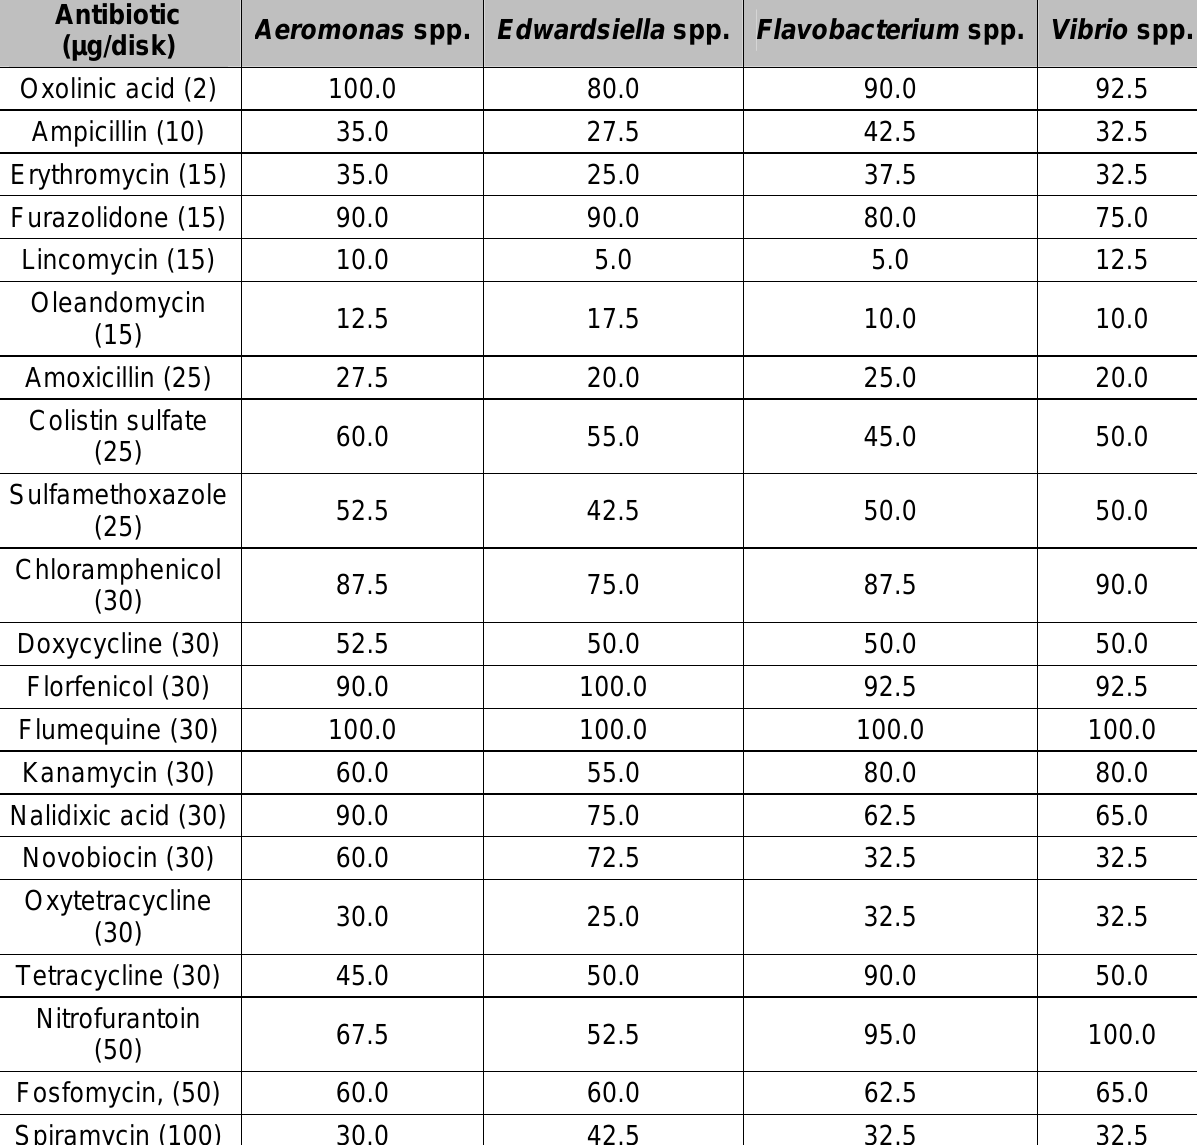
Table 1. Percentage of sensitivity of Aeromonas